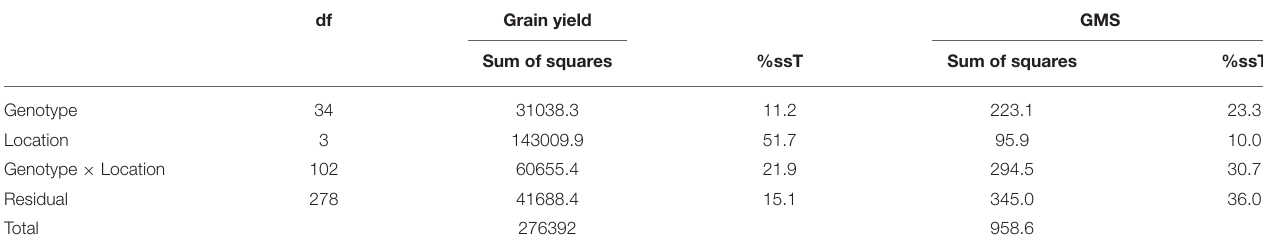
TABLE 5 | Sum of squares and proportion of variation explained by year (Y), location (L), genotype (G), and their interactions on grain yield (GY) and grain mold score